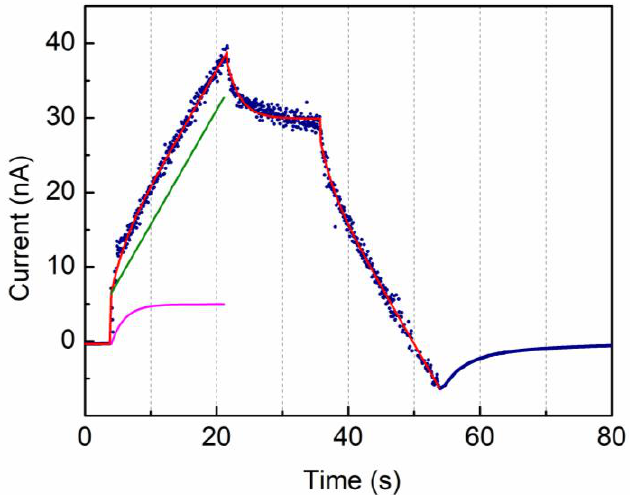
Figure 8. Example of VRM method applied to a 100 µ m thick TPU-CCTO composite. The input voltage ramp-up/down was 5 V/s, and the flat top voltage 100 V. Experimental data (blue marks) are outputs from the picoammeter. The red solid curve corresponds to the best fit made to the data with the analytical curve representing the electrical model of Figure 6a. Referring to that scheme, the solid green curve represents the contribution due to the current through R and C, while the solid purple curve shows the contribution of the currents flowing through C1 and C2.